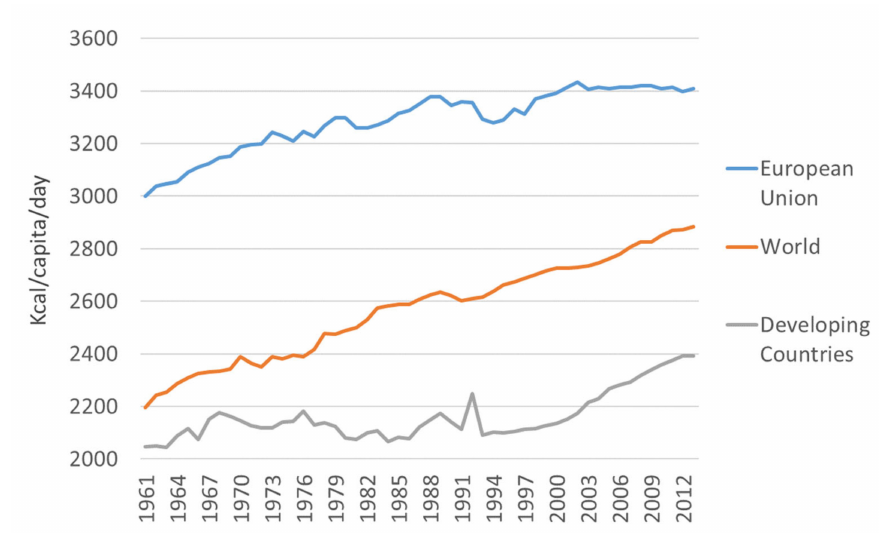
Figure 3. Increase in calorie intake in di ff erent regions over the last 50